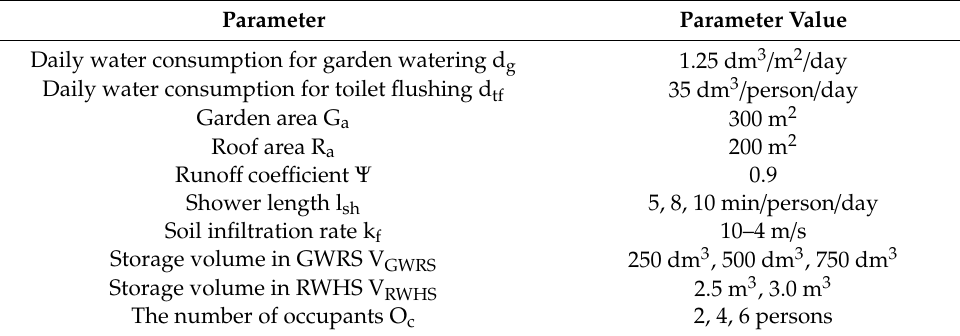
Table 6. Data accepted for calculations for water and sewage